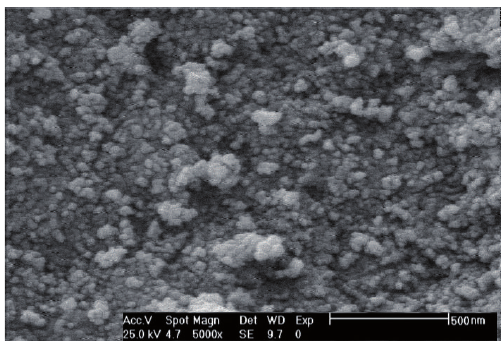
F 1: SEM micrograph of TREN-functionalized Fe